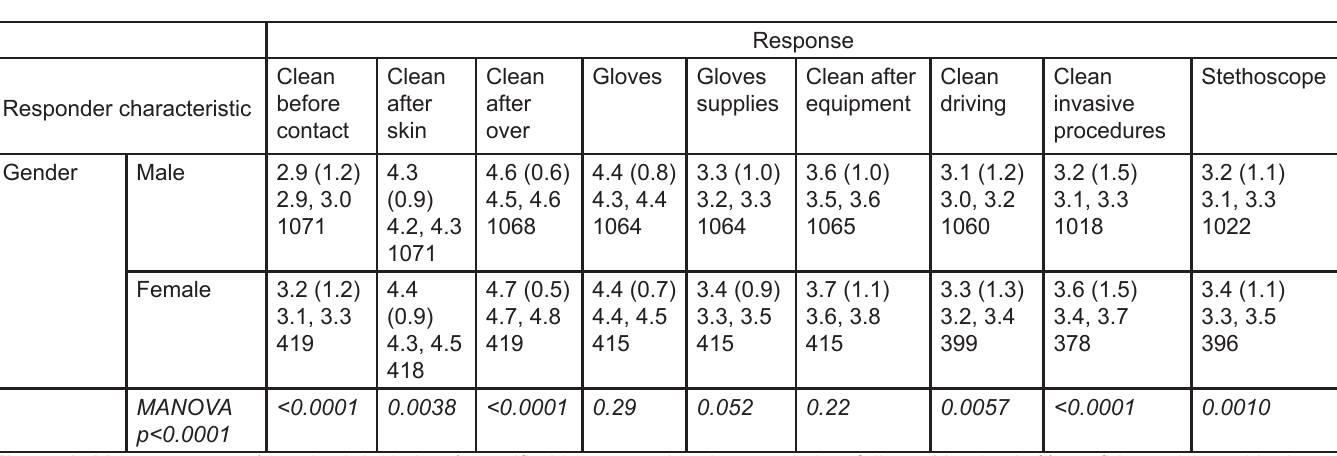
Figure 2. Mean response (standard deviations) stratified by responder characteristics, followed by the 95% confidence interval in the 2nd line, and the absolute number of responses in the 3rd line, per response category. P-values (in italics) are included to test for dif- ferences in means of individual responses based on responder characteristic. Multivariate analysis of variance (MANOVA) p-values test whether there is a measurable collective difference over all